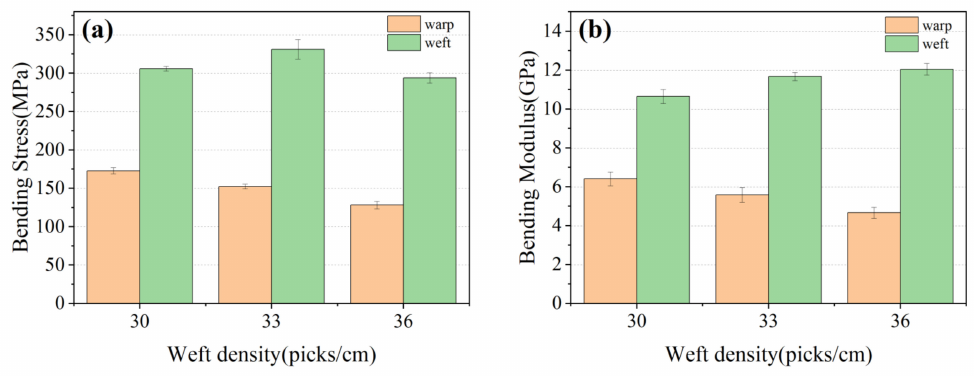
Figure 6. Bending property of 3D armor materials with different weft densities: ( a ) bending strength of the material; ( b ) material flexural modulus.